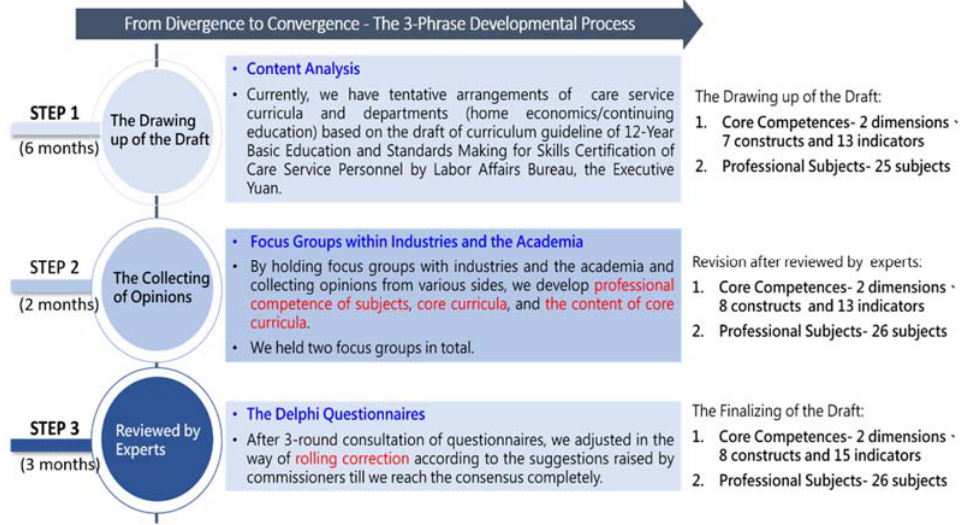
Figure 1. The Graph of Research Procedures.